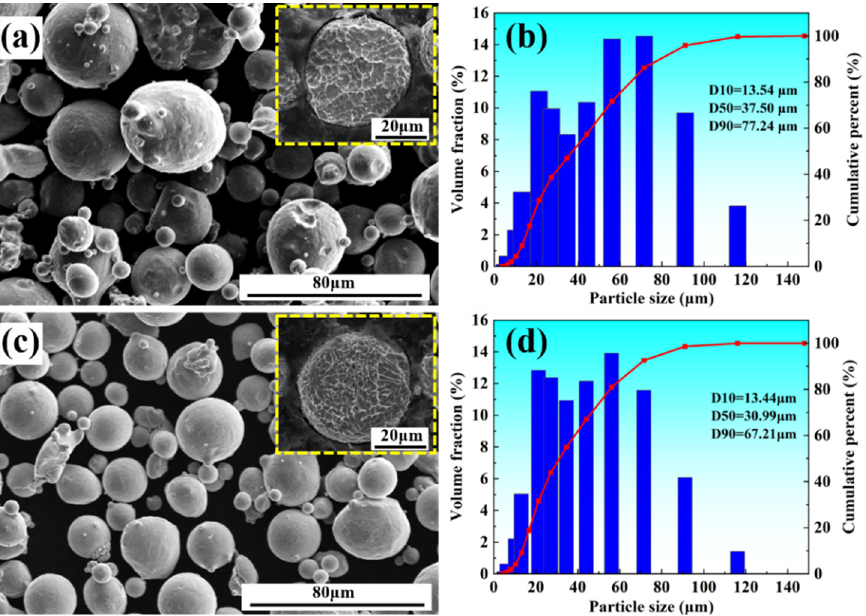
Figure 1. ( a , c ) Morphology of the stainless steel powder without and with Y, respectively; ( b , d ) particle size distribution of the stainless steel powder without and with yttrium, respectively.